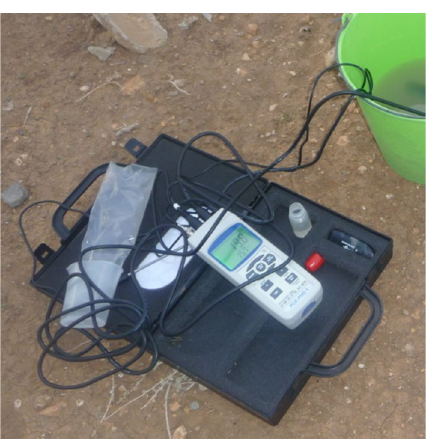
Fig. 3 PCE instrument of type